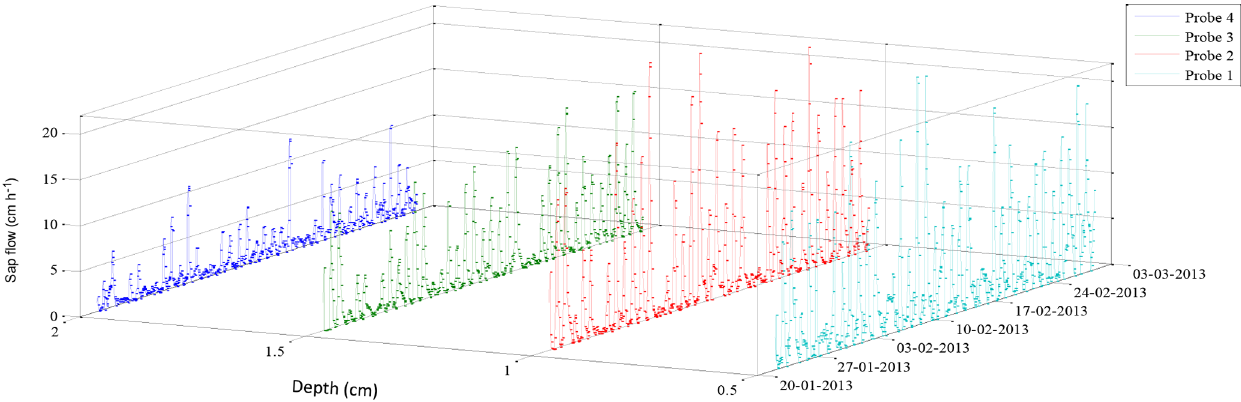
Figure 4. Hourly heat pulse velocity of a G. buxifolia (Ø: 114mm) at New